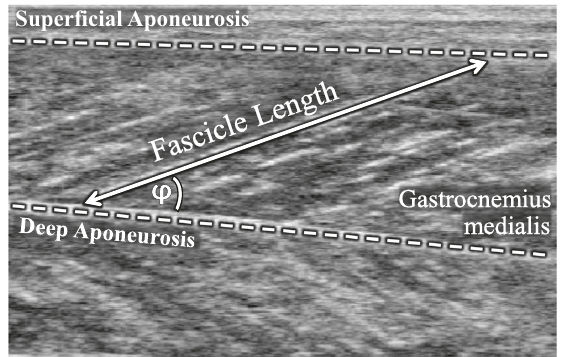
Fig. 4 Ultrasound image of the gastrocnemius medialis with schematic representation of the extracted fascicle parameters. The pennation angle ( φ ) of the muscle fascicles (double-headed arrow) is de fi ned with respect to the deep aponeurosis (lower dashed line). Fascicle length is measured as the length following the pennation between the deep and the super fi cial (upper dashed line)